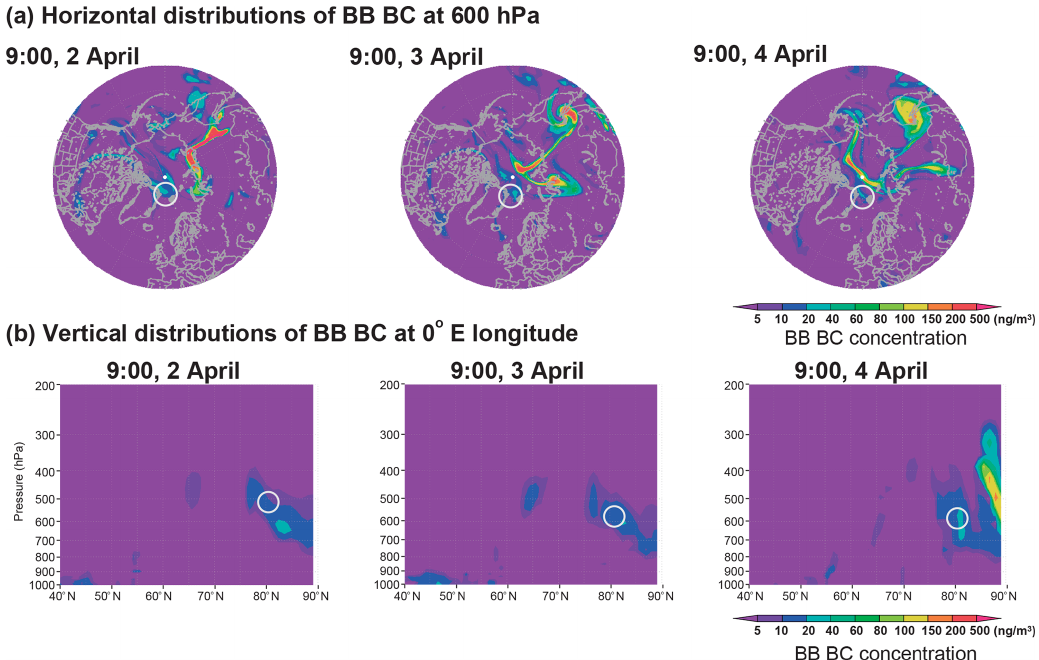
Figure 7. Model simulations of the (a) horizontal and (b) vertical distributions of the mass concentration of BC originating from BB during the sampling periods of the BB samples. The white circles indicate the sampling locations. The transport pathway of the BB plume from its source area is shown in Fig. S2.